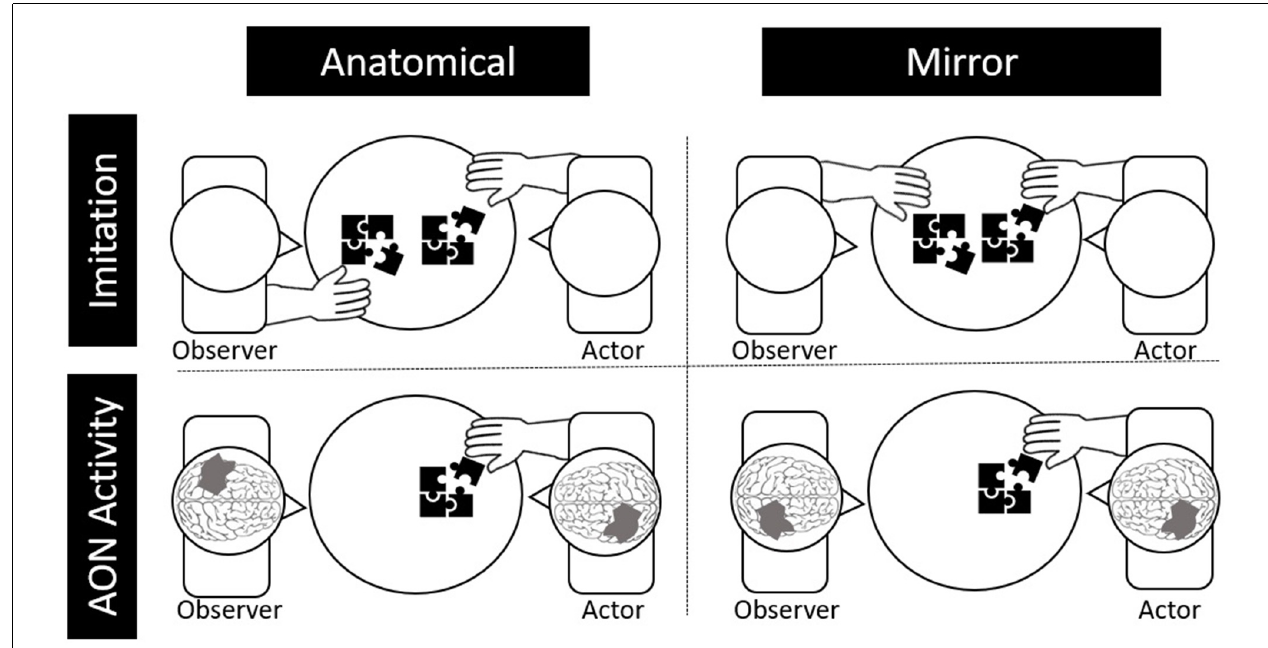
FIGURE 1 | Depictions of anatomical and behavioral imitation (top) and anatomical and behavioral neural activity during observation (bottom).